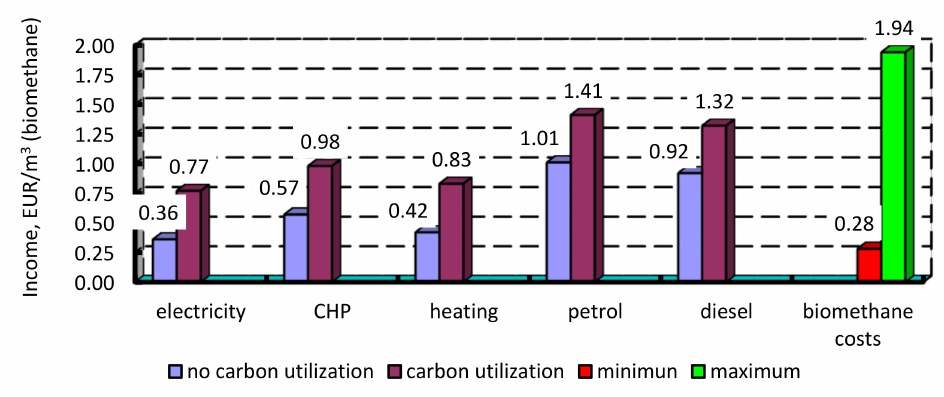
Figure 14. Income from the use of one cubic meter of